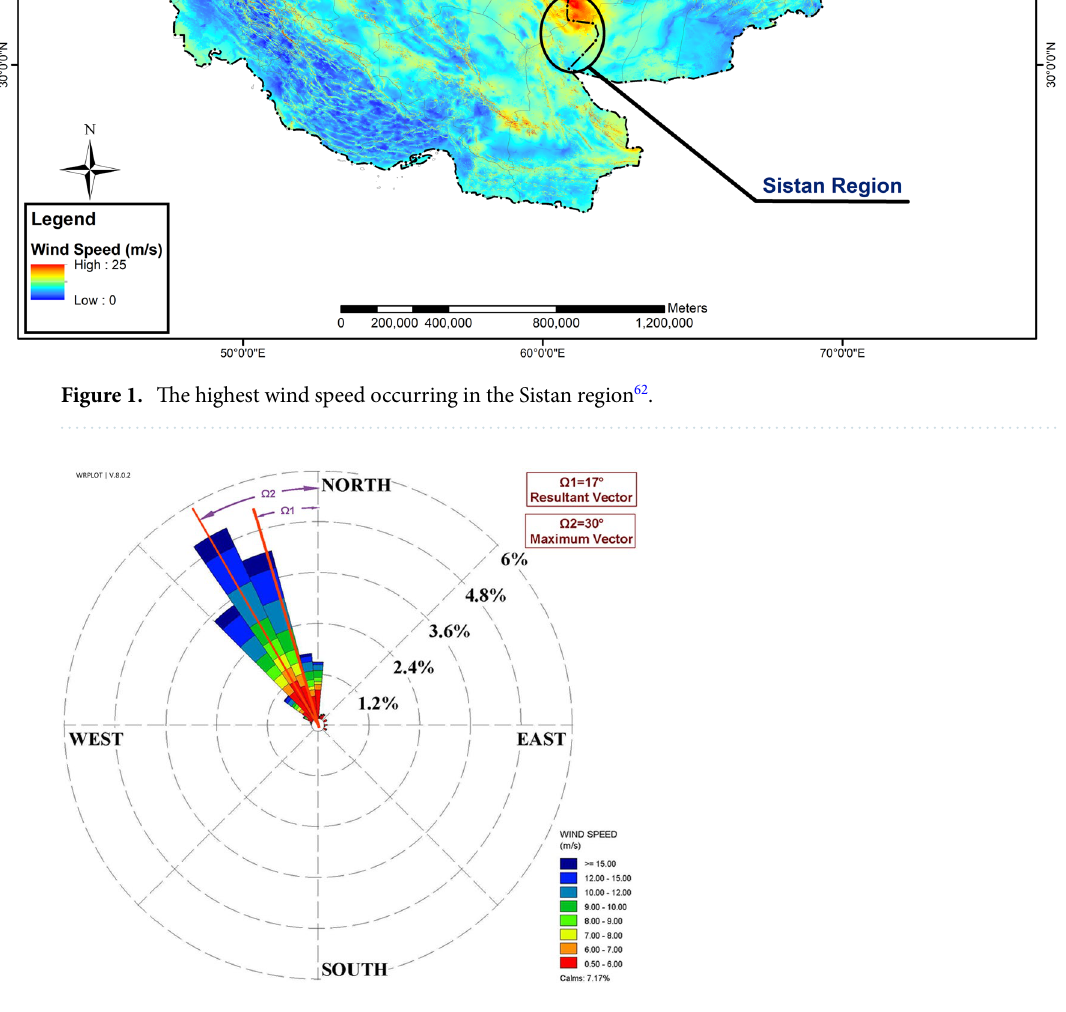
Figure 2. The wind rose of Sistan, as well as two dominant wind